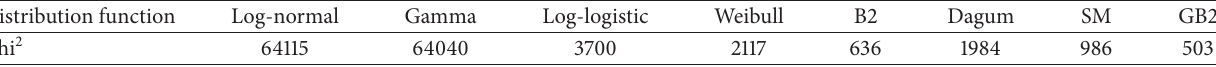
Table 3: Chi 2 values of resident income distribution fitted by different distribution functions in 2012.